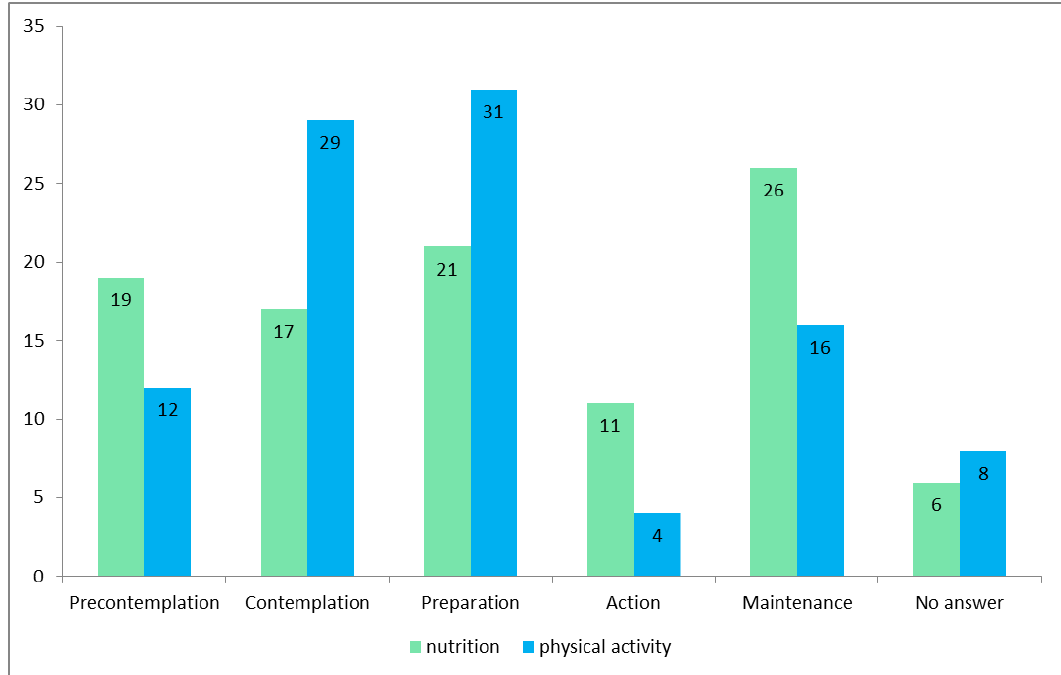
Figure 1. Percentage distribution according to the stage of change.